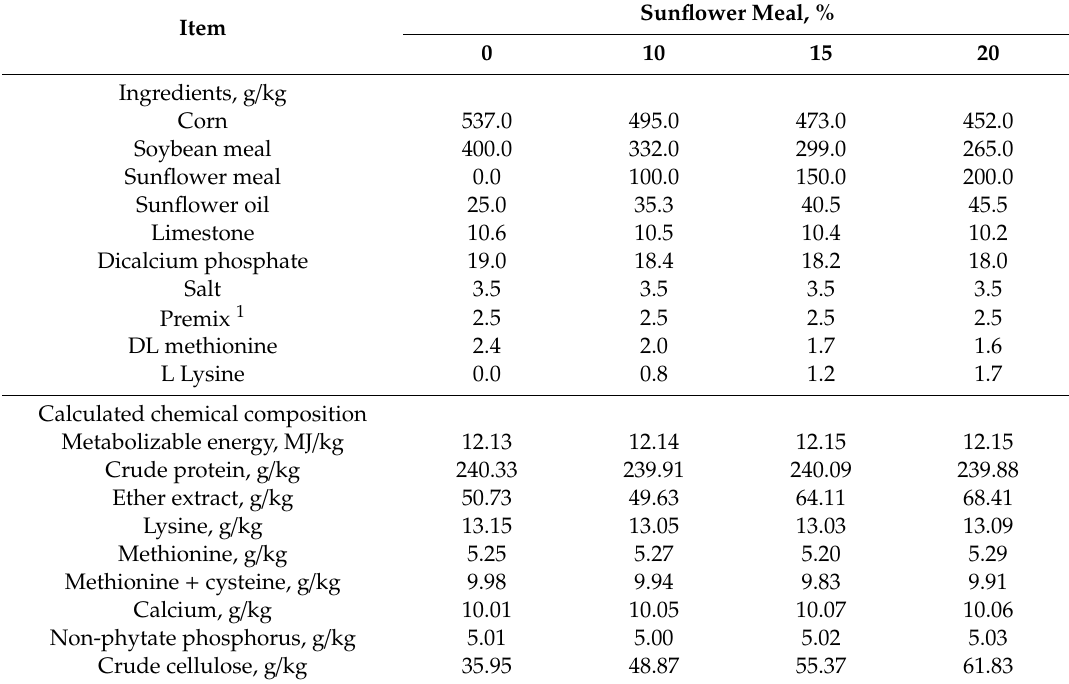
Table 1. Composition of experimental diets and calculated nutrient contents.